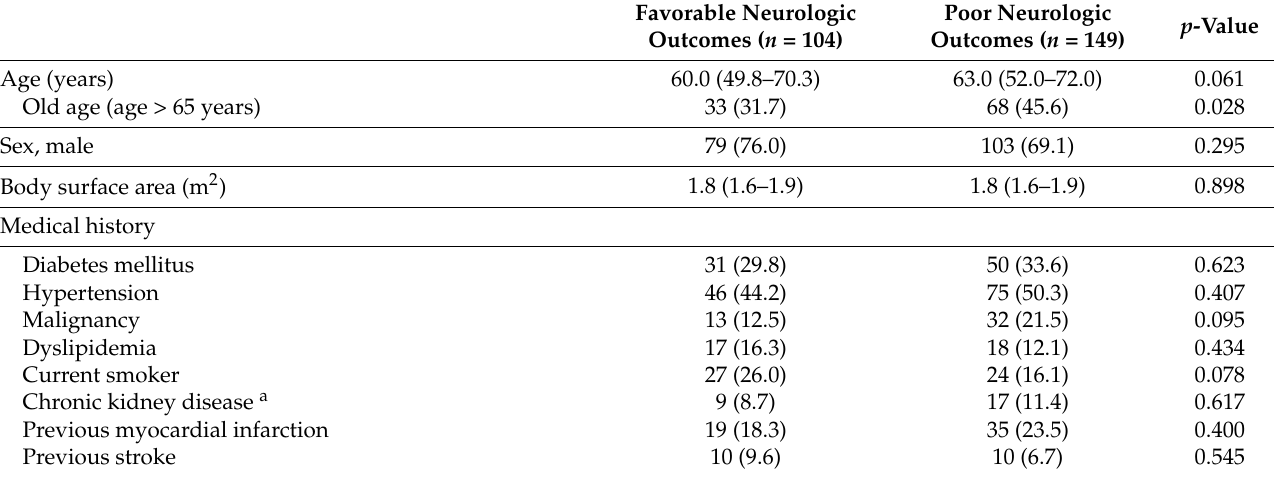
Table 1. Baseline Characteristics of the